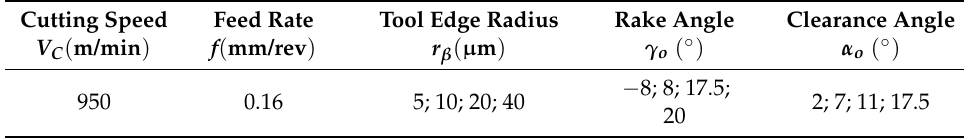
Table 3. Cutting conditions and tool geometry